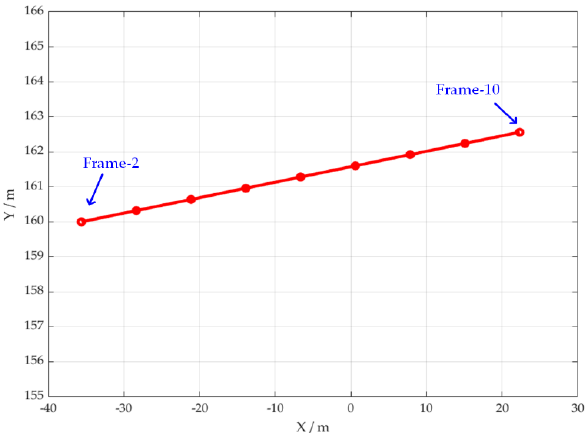
Figure 18. The estimated target track using the experiment data.